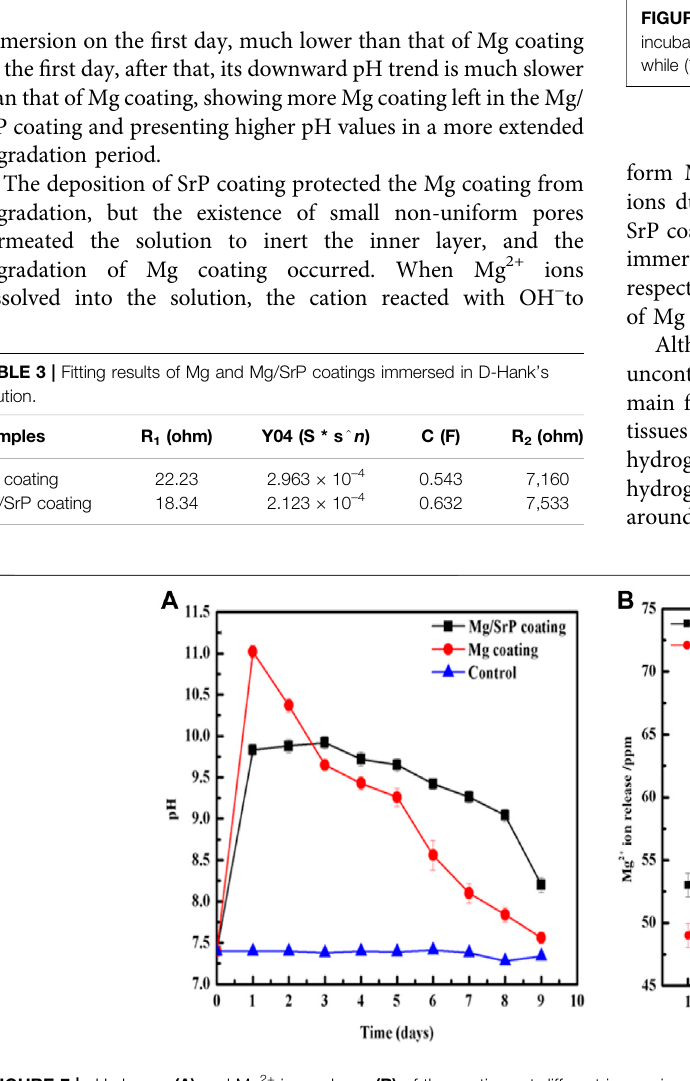
FIGURE 7 | pH change (A) and Mg 2+ ions release (B) of the coatings at different immersion time in D-Hank ’ s solution.